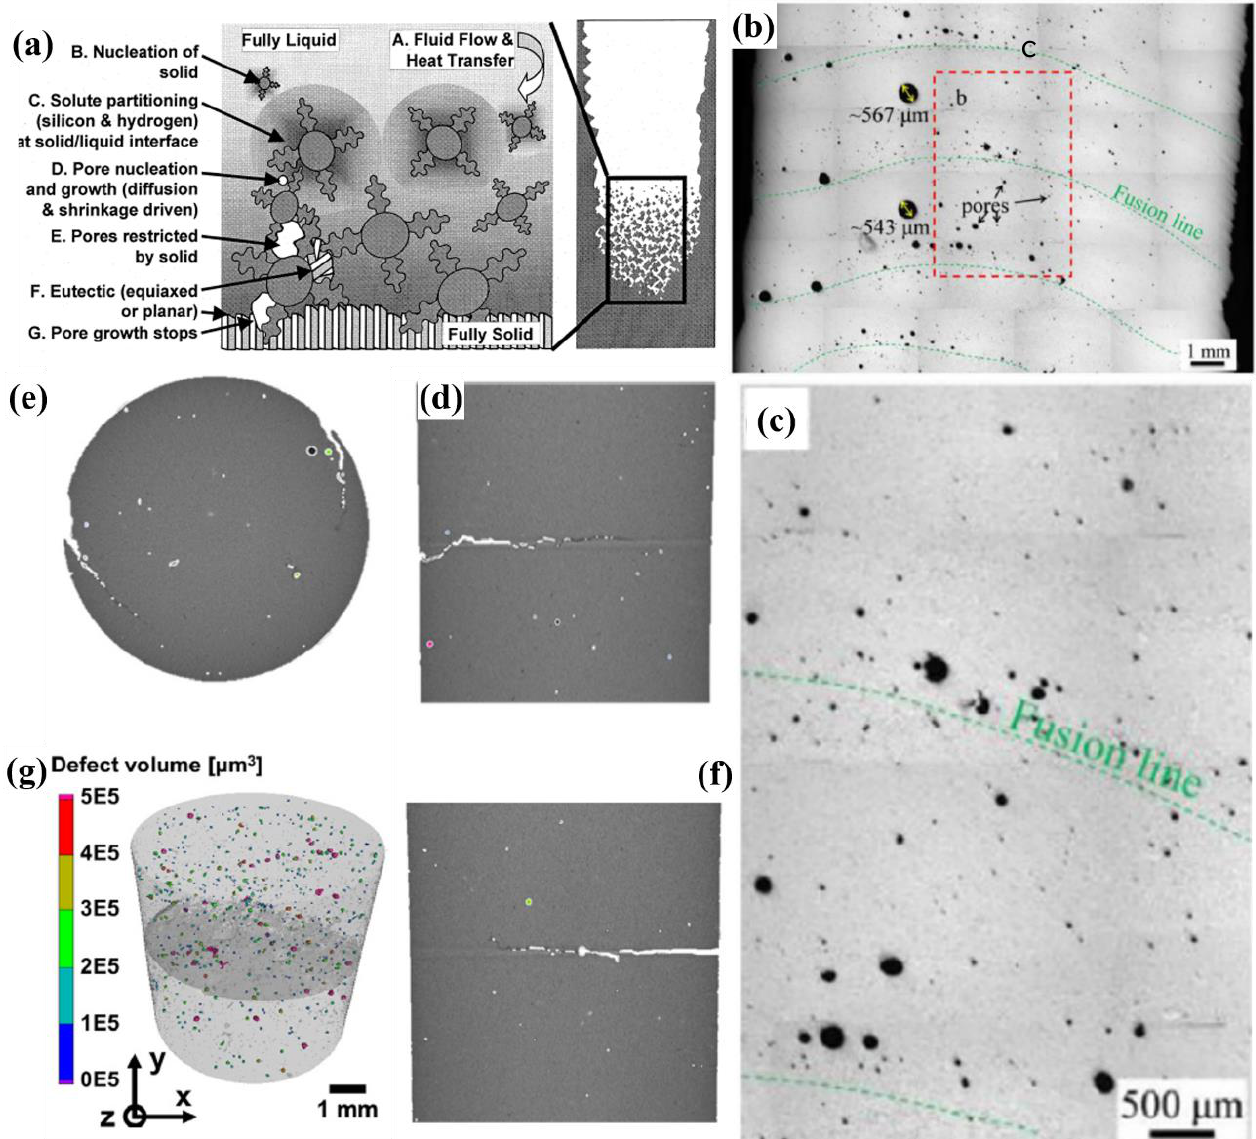
Figure 7. ( a ) Schematic illustration of the physical processes for the inception of microporosities in Al-Si alloys [206]. ( b , c ) Pore distribution in wire-arc additively manufactured Al-Si alloy [127]. ( d ) Front view, ( e ) top view, ( f ) side view, and ( g ) isometric view from X-ray microcomputed tomog- raphy showing pore-crack deflection mechanism under 20 kHz testing frequency at 95 MPa stress amplitude for SLMed Al-10%Si-Mg alloys [125]. Reproduced with permission from